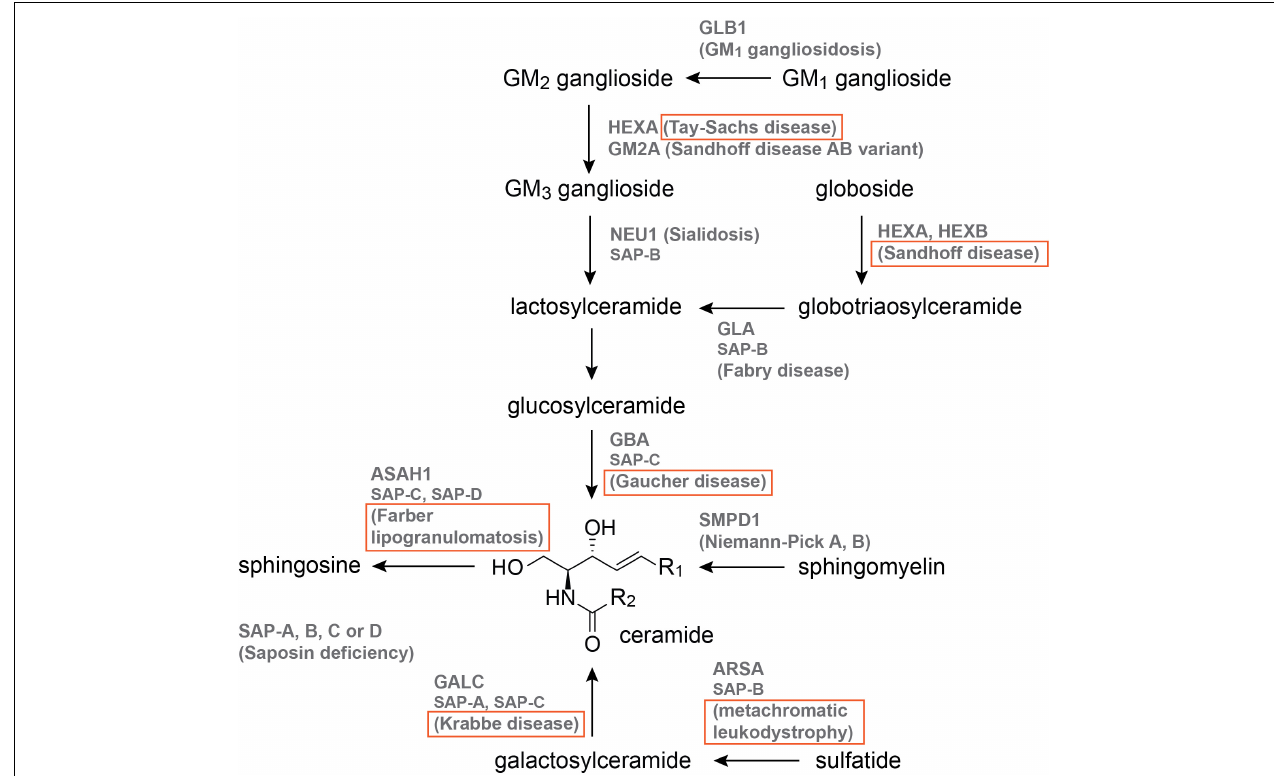
FIGURE 2 | The sphingolipid catabolic pathway. Names that are boxed have published zebrafish models. Pathway illustration is based on Özkara